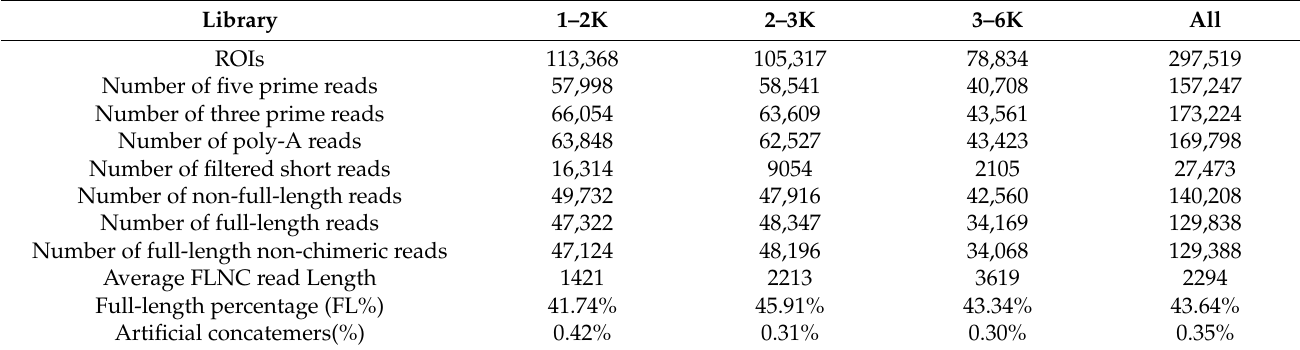
Table 2. Statistics of F01 libraries of different